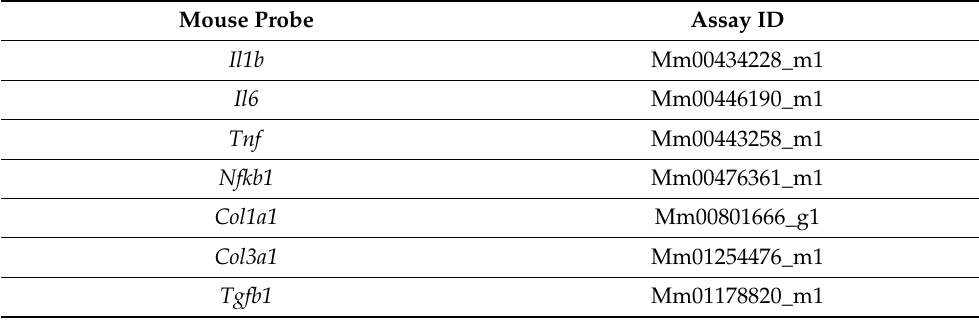
Table 3. Assay id probes in real-time